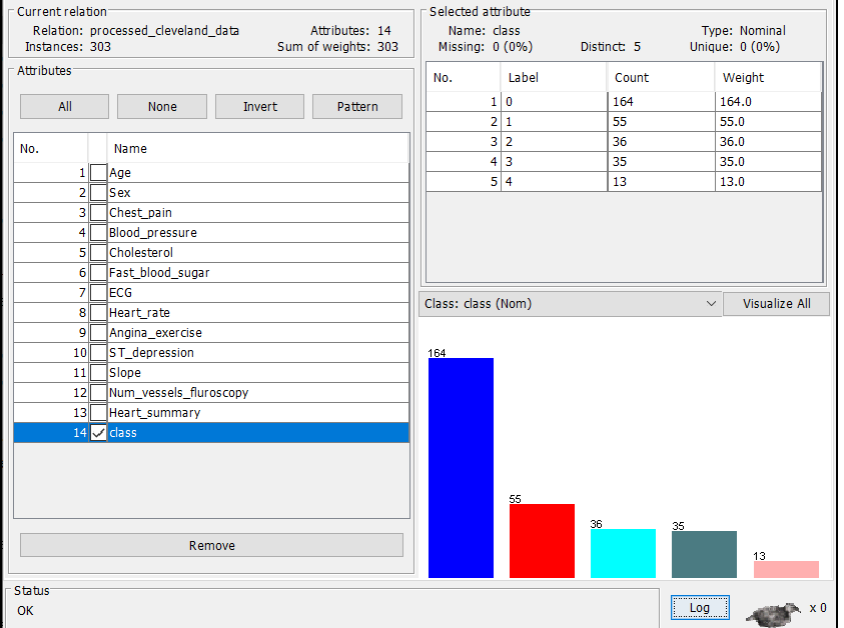
Figure 6. The Cleveland dataset characteristics: number, name of attributes, and distribution per cluster.